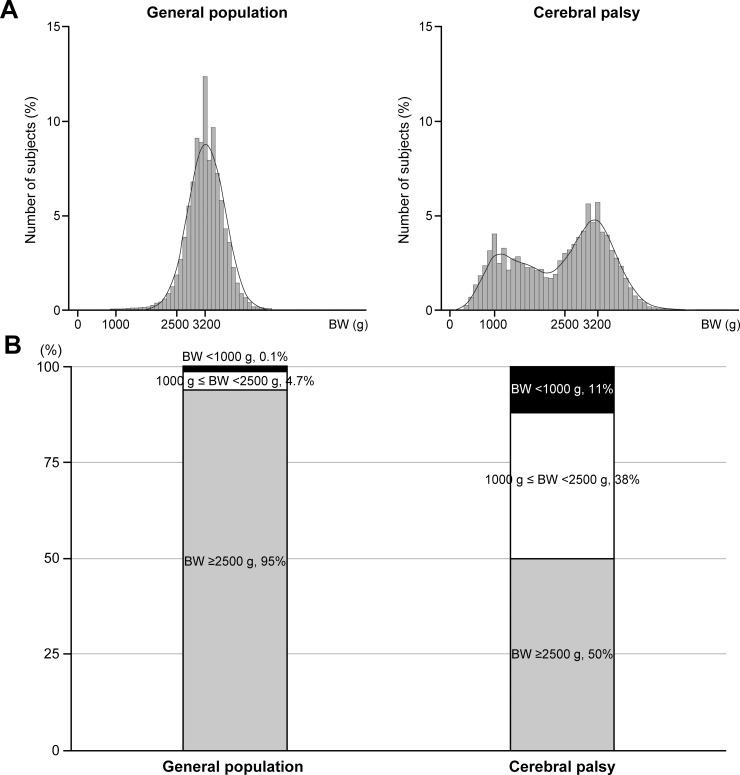
Comparison of birth weight (BW).(A) Distribution of subjects by BW. (B) Distribution of subjects by stratification of BW. Comparison was made between subjects in the general population and subjects with cerebral palsy.